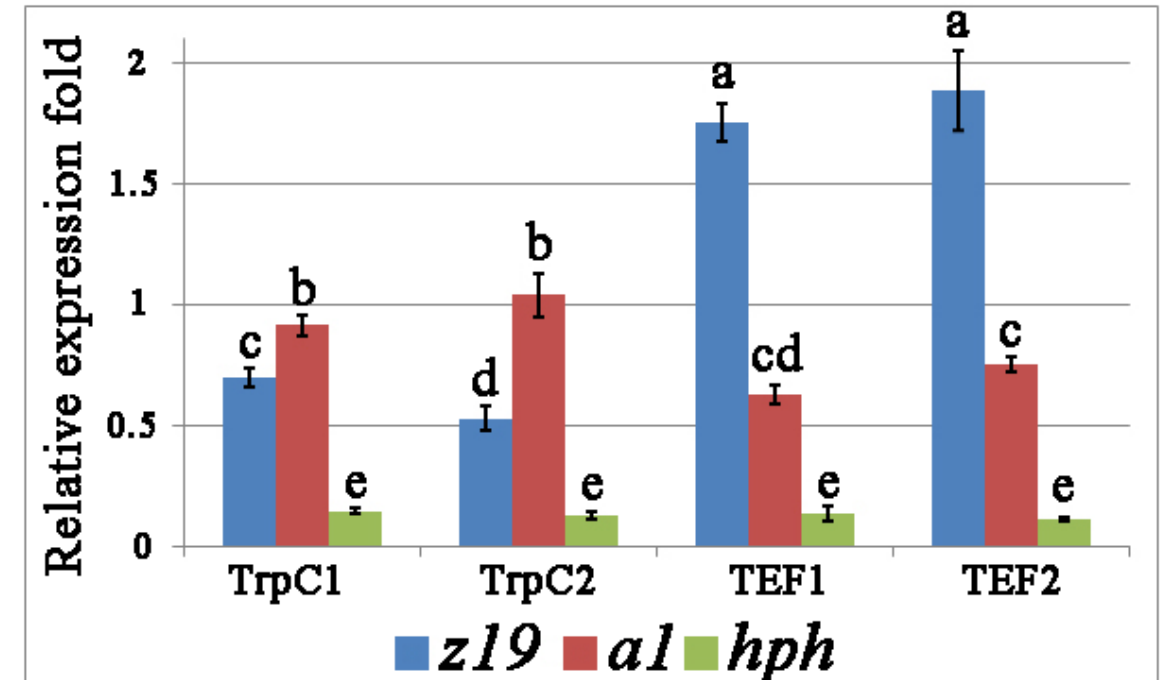
Figure 3. qPCR analysis of z19 , a1 , and hph expression in Th. thermophilus rF-859 strains. Two recombinant clones of Th. thermophilus rF-859 harboring the z19 and a1 genes driven by P trpC (named TrpC1 and TrpC2), as well as two clones expressing the same genes regulated by P tef (named TEF1 and TEF2) were analyzed. In all studied clones hph gene was driven by P trpC. Different letters above the bars indicate statistically significant differences of means ( p < 0.05) for each of the gene, Fisher’s LSD.